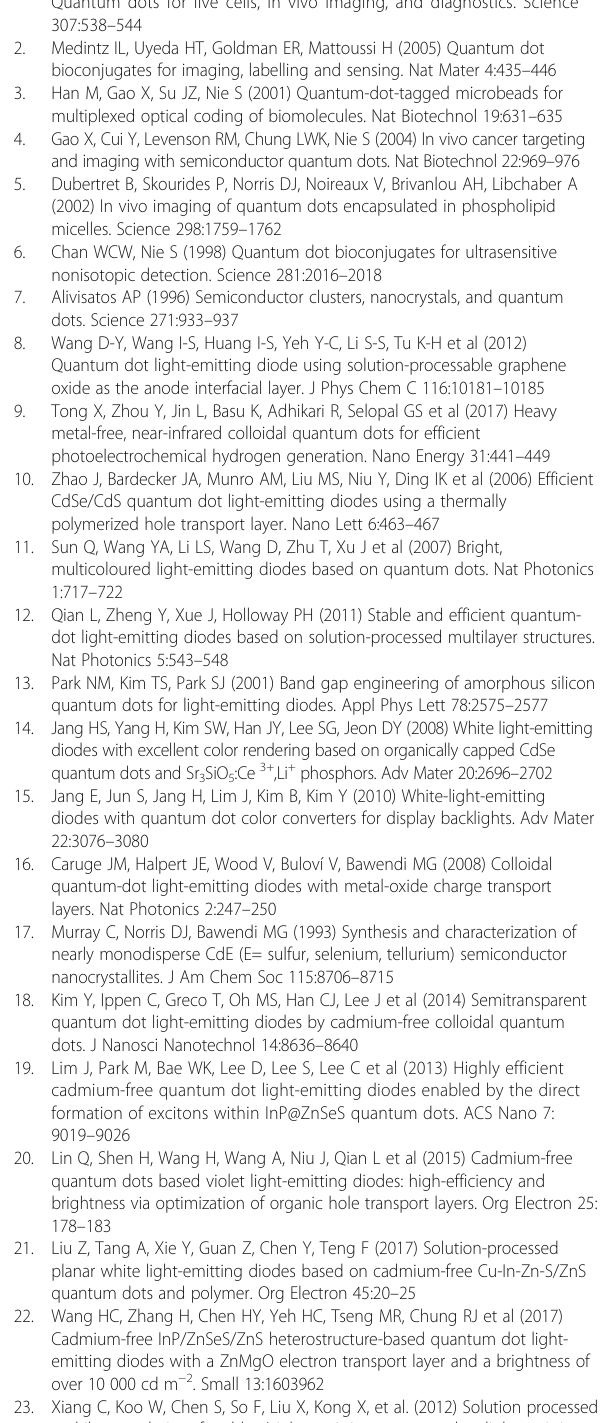
fitting. Figure S2. EDX analysis of InP/ZnS core/shell QDs. Figure S3. a UV-Vis spectra and fluorescence of InP/ZnS core/shell QDs with red fluorescence. b UV-Vis spectra and fluorescence of InP/ZnS core/shell QDs with yellow fluorescence. c The red (right) and yellow (left) fluorescence of InP/ZnS core/shell QDs with the irradiation by hand-held long-wave UV lamp. (DOC 559